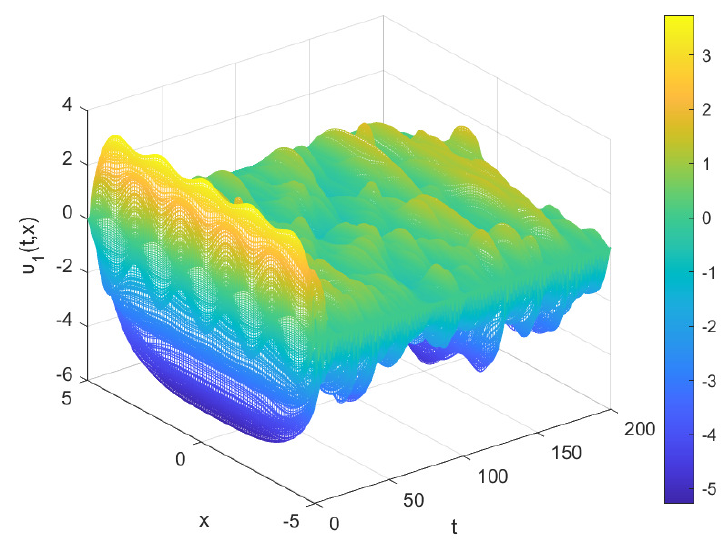
Figure 1. Time valuation of υ 1 ( t , x ) in system